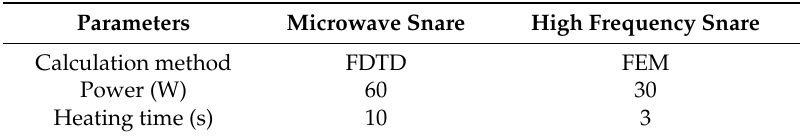
Table 1. Analytical